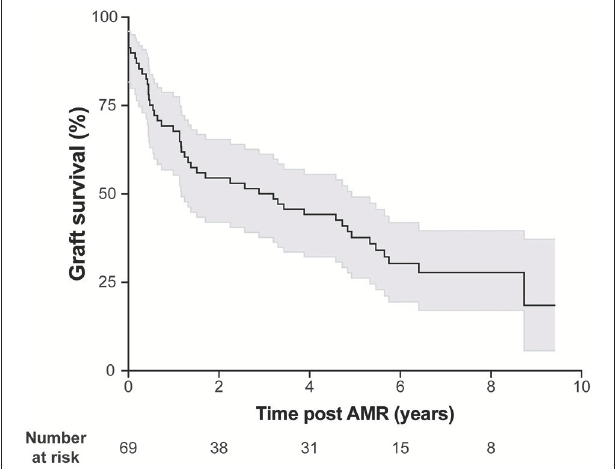
FIGURE 2 | AMR is associated with heterogeneous kidney graft survival. Kidney graft survival of patients diagnosed with AMR. Gray shading indicates 95% confidence